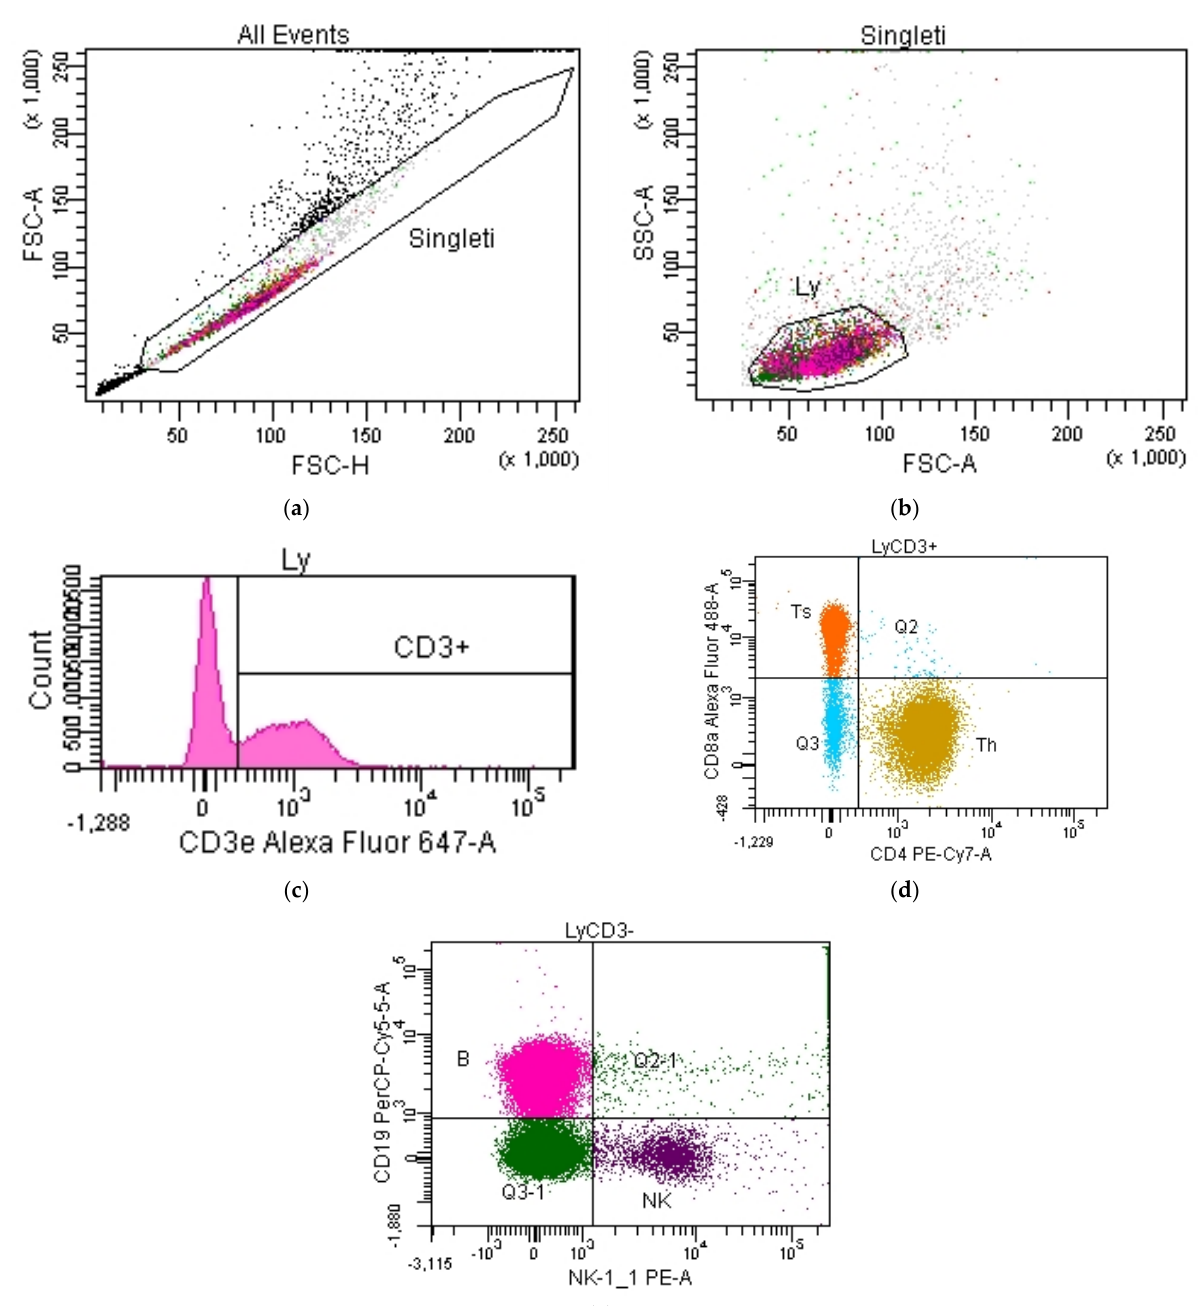
Figure 6. ( a ) Selection of singlet events. In an FSC-H/SSC-A dot-plot , the Singleti gate was constructed in which siglet events were included. The introduction of cellular aggregates into the analysis was avoided. ( b ) Selection of the lymphocyte population. From the gate containing the singlet events, the Ly gate (FSC-A/SSC-A) was constructed in which lymphocytes were isolated. ( c ) Selection of CD3ε+ lymphocytes. Using a histogram (CD3ε/Count), the population of CD3ε+ lymphocytes (total T lymphocytes) was isolated. The CD3ε- lymphocytes were virtually isolated using the ”invert gate” function. ( d ) Selection of Th and Ts lymphocytes. From the T lymphocytes (CD3ε+), using a CD4/CD8a dot-plot with a quadrant, we isolated the Th (helper) lymphocyte subpopulations with the phenotype CD3 ɛ +CD4+CD8a− and Ts subpopulations (suppressor/cytotoxic) with the phenotype CD3 ɛ +CD8a+CD4−. ( e ) Selection of B lymphocytes and NK cells. From CD3 ε -negative lymphocytes, B lymphocytes (phenotype CD3 E − CD19+NK1.1 − ) and NK cells (phenotype CD3 E − CD19 − NK1.1+) were